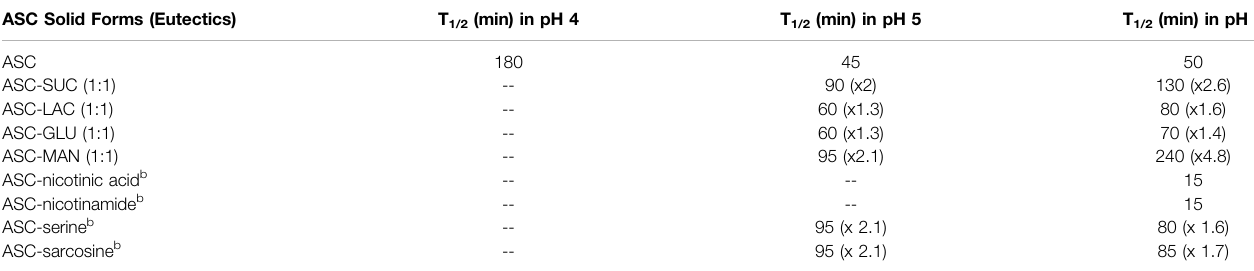
TABLE 2 | Half-life period (T 1/2 , min) of ASC binary systems in buffer media a, b . ASC Solid Forms (Eutectics)